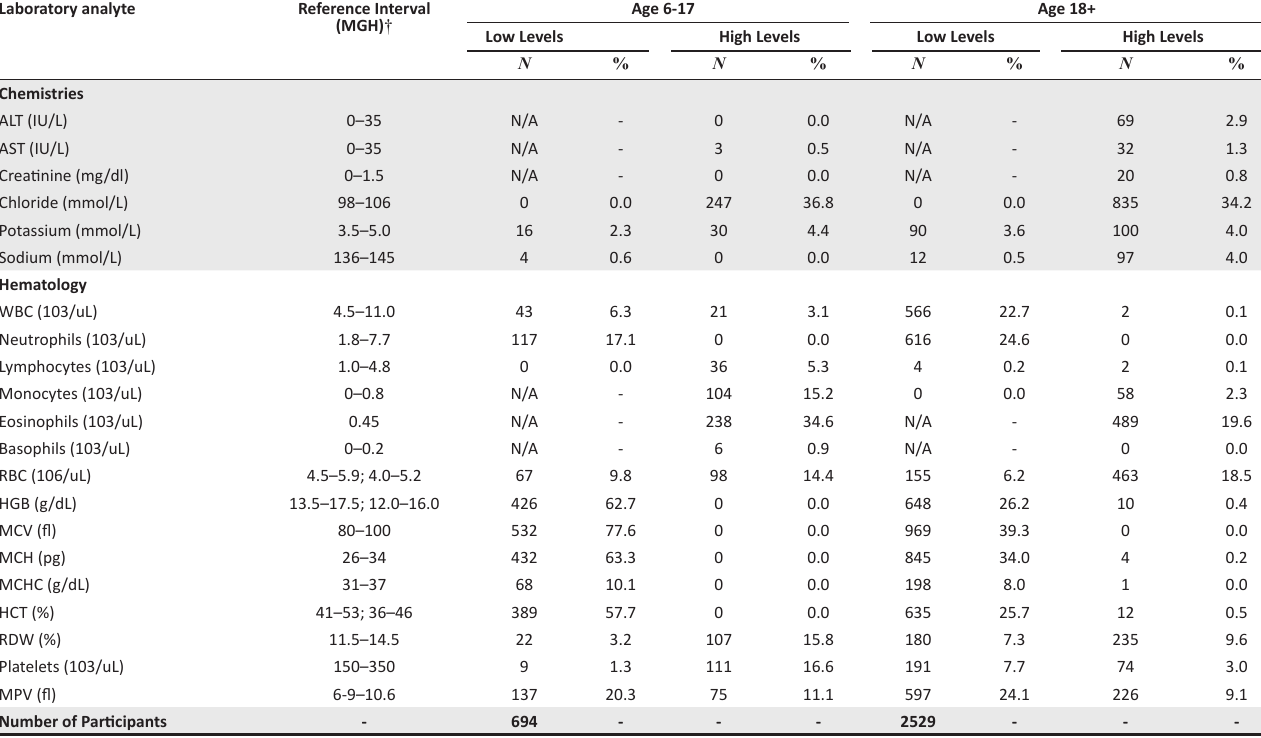
TABLE 3: Percentage of Study Participants Outside of US1 Reference Intervals: Monrovia, Liberia 2015-2017 Laboratory